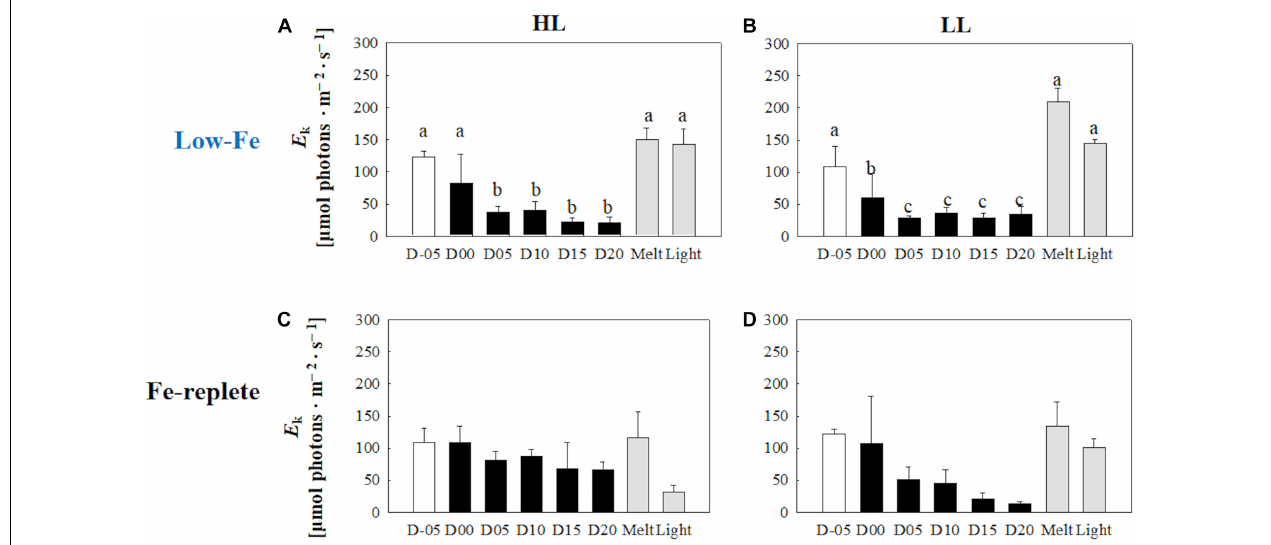
FIGURE 8 | Light saturation index ( E k ) calculated from the photosynthesis-irradiance (ETR RCII - E ) relationship at each sampling time point during the ice tank incubation experiments. Panels (A,B) show E k values of the low-Fe ice tank runs in this study, whereas panels (C,D) show those of Fe-replete ice tank runs modified from Yoshida et al. (2020). Left (A,C) and right (B,D) panels indicate data from the HL and LL treatments, respectively. Open, closed, and shaded bars indicate values of pre-freeze seawater, ice, melted seawater samples, respectively. Letters above bars in a panel indicate significant differences in values between sampling days with one-way ANOVA with Tukey’s test; there is no significant difference between values if a given letter is shown in the combination of letters of the counterparts. The D stands for “day,” while Melt and Light indicate values after melting and light exposure experiments, respectively. Error bars show 1 standard deviation ( n = 6). One-way ANOVA with Tukey’s test, HL: F ( 7 , 47 ) = 12.88, p < 0.001; LL: F ( 7 , 47 ) = 41.46, p < 0.001. Two-way ANOVA test with Tukey’s test, Light: F (